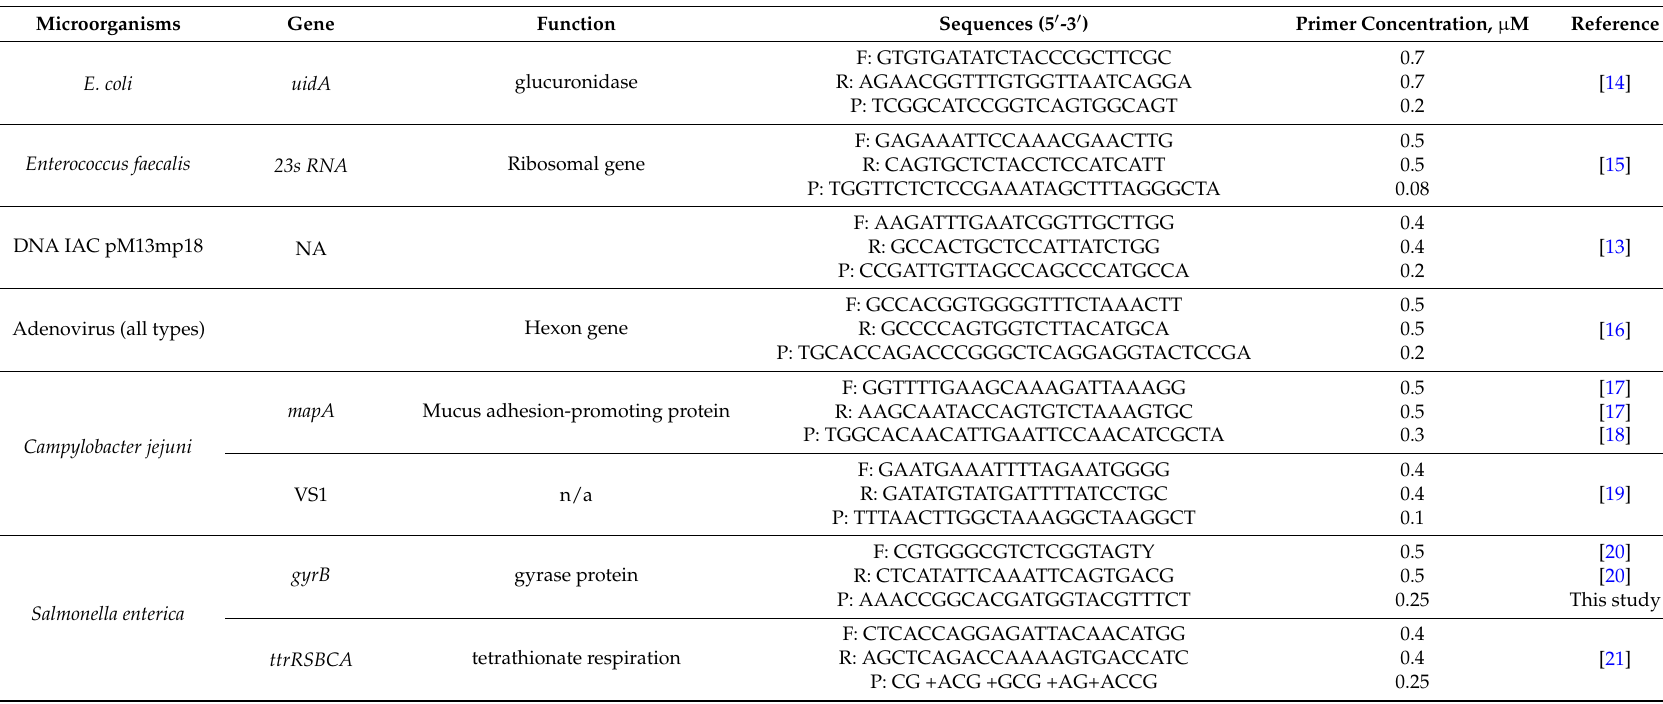
Table 2. Sources and concentrations of primers and probes with fluorescence label used for qPCR assays to quantitatively detect